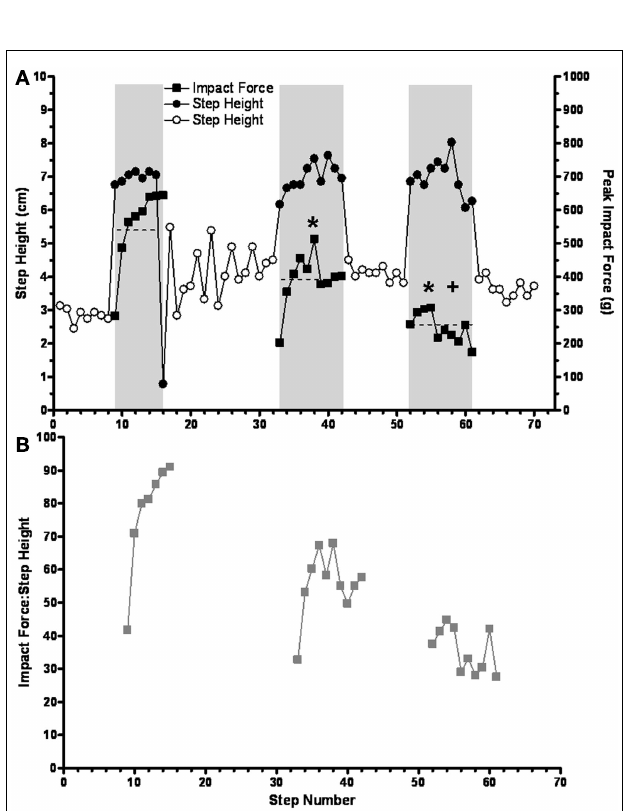
FIGURE 7 | (A) The mean impact force on the trip rod (horizontal dashed lines) is shown to progressively decrease during three successive short trip-release sequences. Solid symbols, trip steps; open symbols, control steps; shaded areas, trip series. (B) The ratios of peak impact force and step height are shown for the same trip sequences in (A) . Note that the results in both (A) and (B) reflect a learning-related phenomenon that occurs over a time frame of seconds. * and + Significantly different from the first and second trip sequence, respectively.